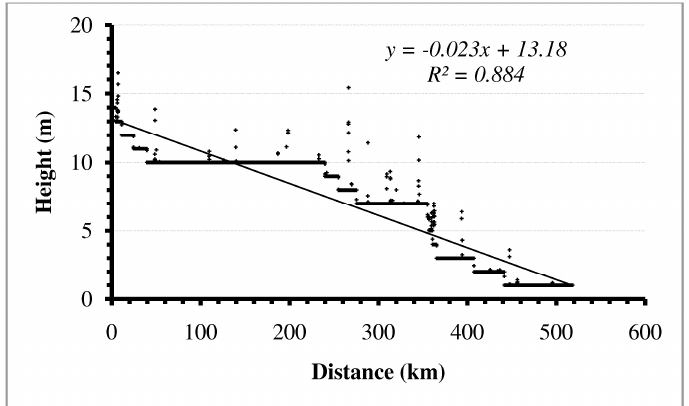
Figure 11. Average slope between stations A and B, indicated by the major diagonal. The solid points are the elevation values for the center line of river segments extracted from the DEM map. The solid points in sections with gently sloping terrain translate into a thick horizontal line.